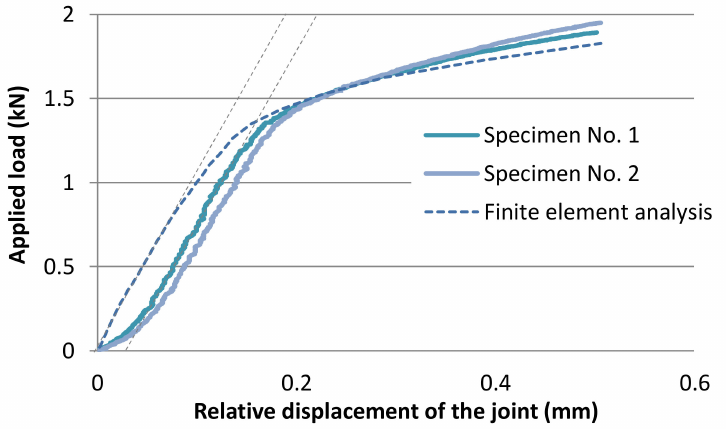
Figure 4. Relationship between applied load and relative displacement where Fsq = 13 kN.